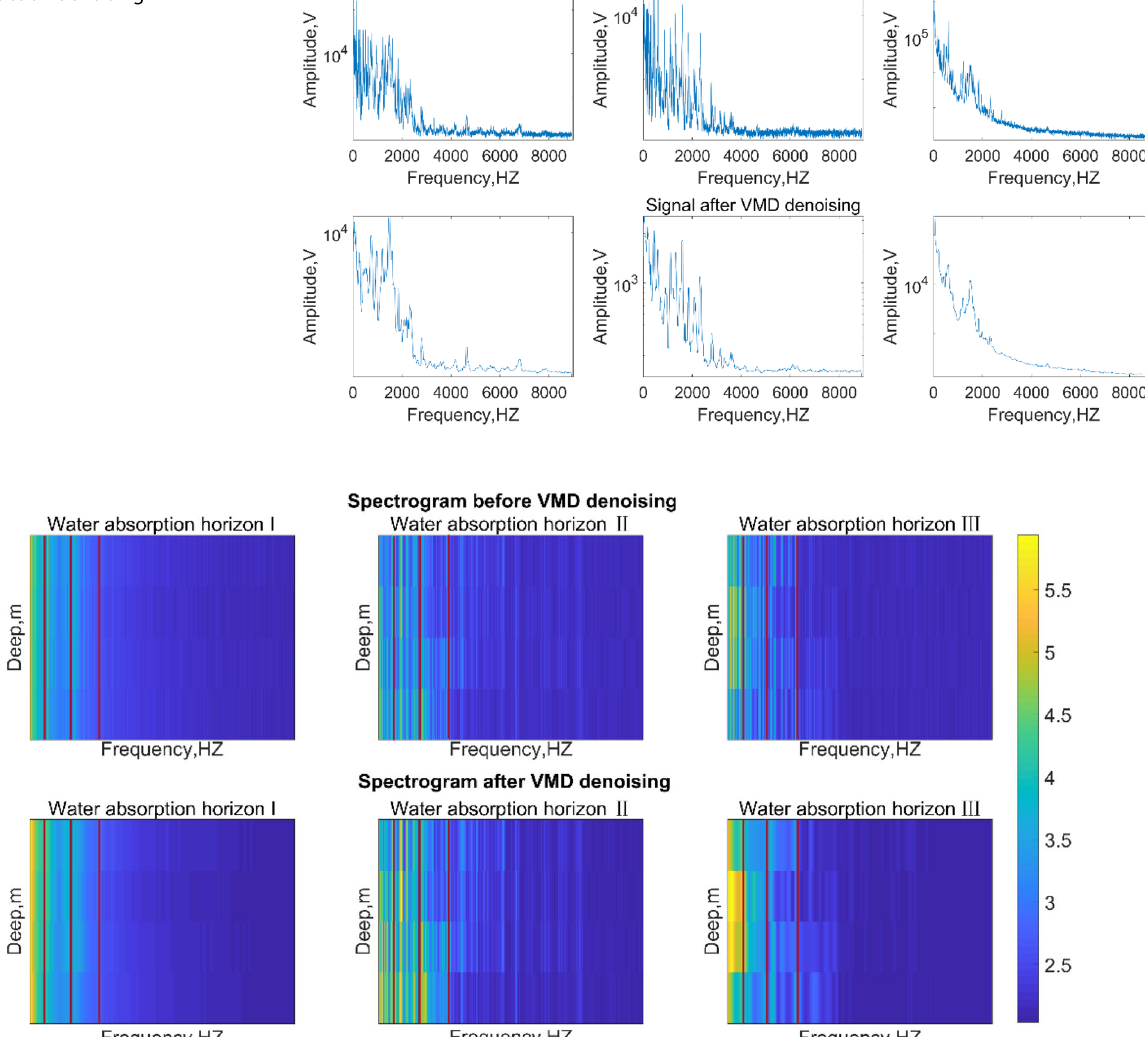
Fig. 5 VMD decomposition reconstruction denoising